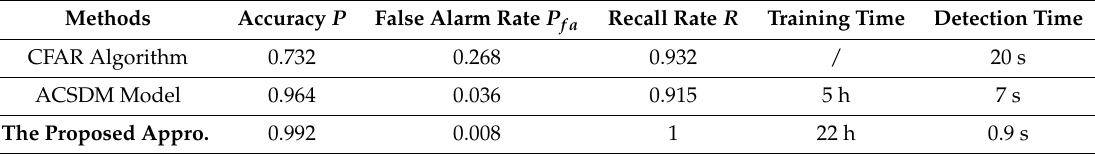
Table 4. Measuring indexes of different methods.